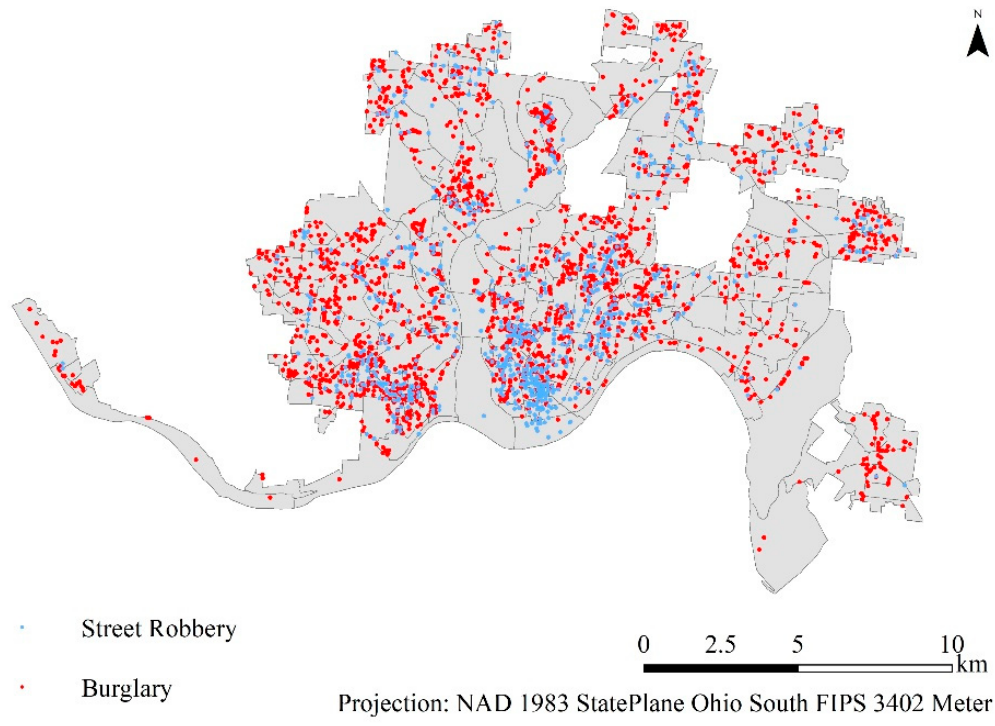
Figure 3. Street robbery and burglary in Cincinnati.